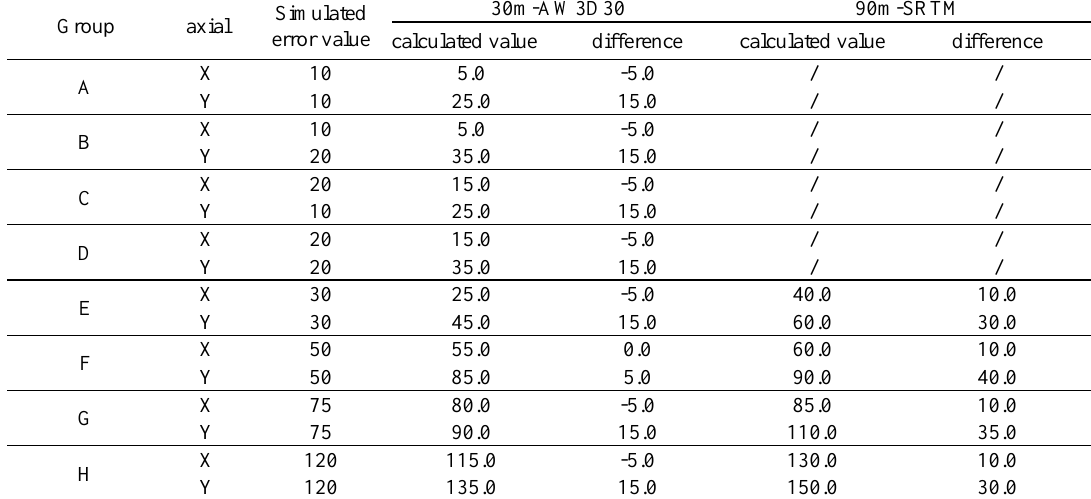
Table 2. Statistical table of pointing angle error calculated by sparsed GLAS laser data